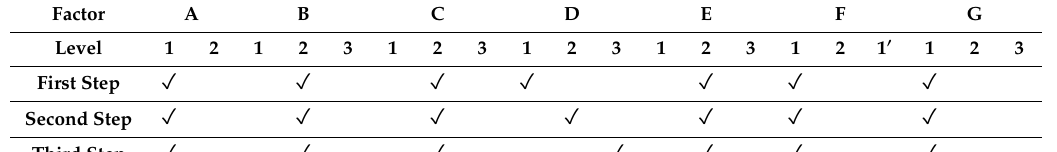
Table 7. Result of implementing parameter tuning.